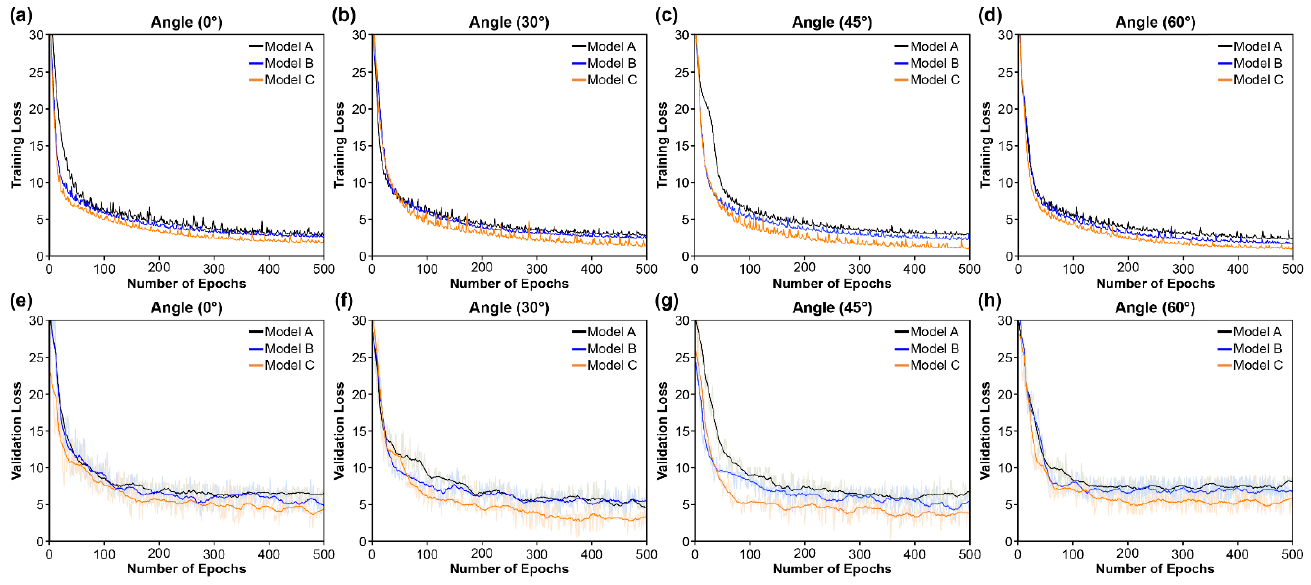
Figure 5. Training and validation loss comparing convergence speed of convolutional layers (Models A, B, and C): ( a – d ) Training loss at ( a ) 0°; ( b ) 30°; ( c ) 45°; and ( d ) 60°; ( e – h ) Validation loss at ( e ) 0°; ( f ) 30°; ( g ) 45°; and ( h ) 60°.